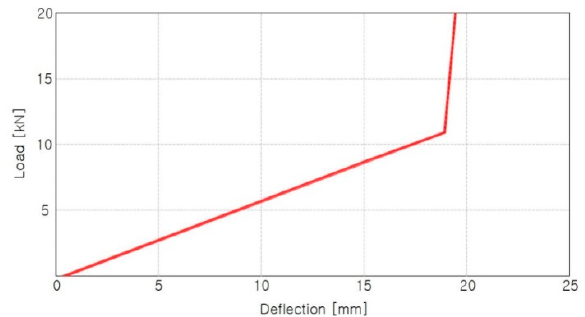
Figure 3. Load–deflection diagram for tension clamp (SKL15).